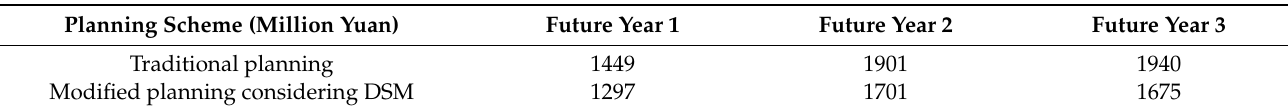
Table 7. Comparison of the investment